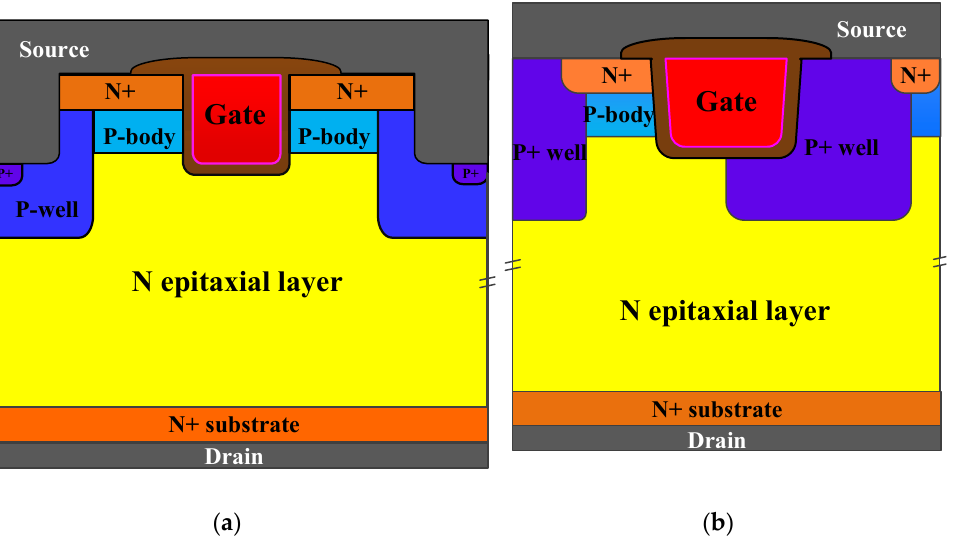
Figure 1. Schematic cross-sections of different trench-gate SiC MOSFETs. ( a ) The double-trench SiC MOSFET and ( b ) the asymmetric trench SiC MOSFET. Table 1. Device electrical parameters.